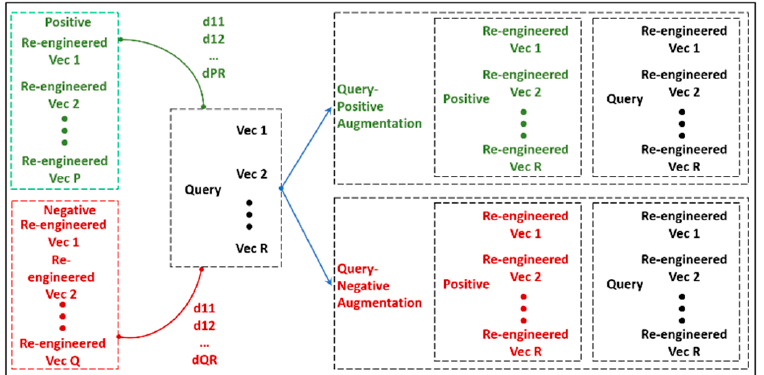
Figure 3. The interactive test stage of the proposed mechanism using a binary sentiment analysis scenario as an example. Each value per component from the vector of one class is compared with the same component from vectors in the query set for similarity measurements. The values of each component in the query set are then reordered according to ascending distance measurements (N = 100). A separately re-engineered query set is produced for each class.